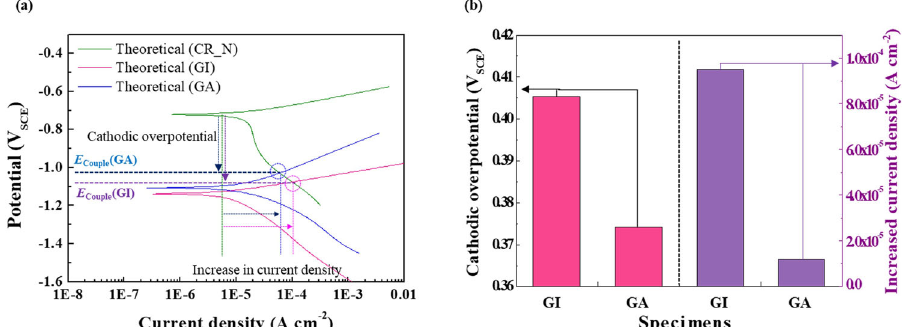
Fig. 12 Electrochemical analysis of galvanic couple (steel substrate-two types of coated steel). a Potentiodynamic polarization curves obtained in a 3.5% NaCl + 0.3% NH 4 SCN solution, indicating the galvanic couple potentials ( E couple (GI-CR_N), E couple (GA-CR_N)), applied cathodic polarization levels on CR_N with GI and GA, respectively, and the increased current densities on CR_N, polarized cathodically, by galvanic coupling with GI and GA, respectively. b Quantitative representation of the parameters (applied cathodic polarization and increased current density), marked on a .